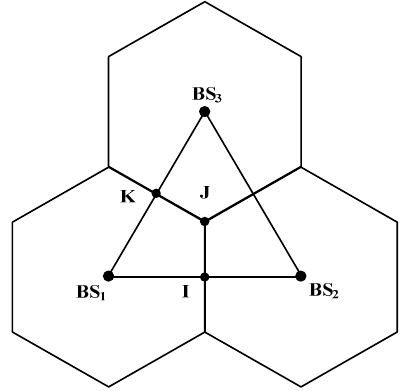
Figure 3. Cell layout showing the relationship between the base stations (BSs) and the inter-BS distances.